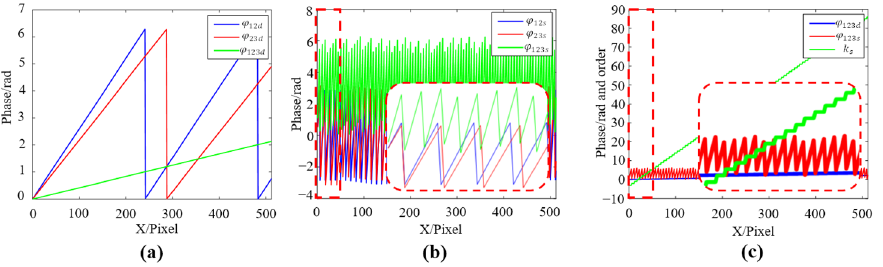
Figure 4. Phase calculation process. ( a ) Phase difference operation ( b ) Phase sum operation. ( c ) Phase unwrapping, k s is the fringe order of ϕ 123 s (the area with a dashed line has 0 to 50 pixels). Figure 4a,b are the synthetic phase profiles obtained by phase difference and phase sum operations. In Figure 4c,